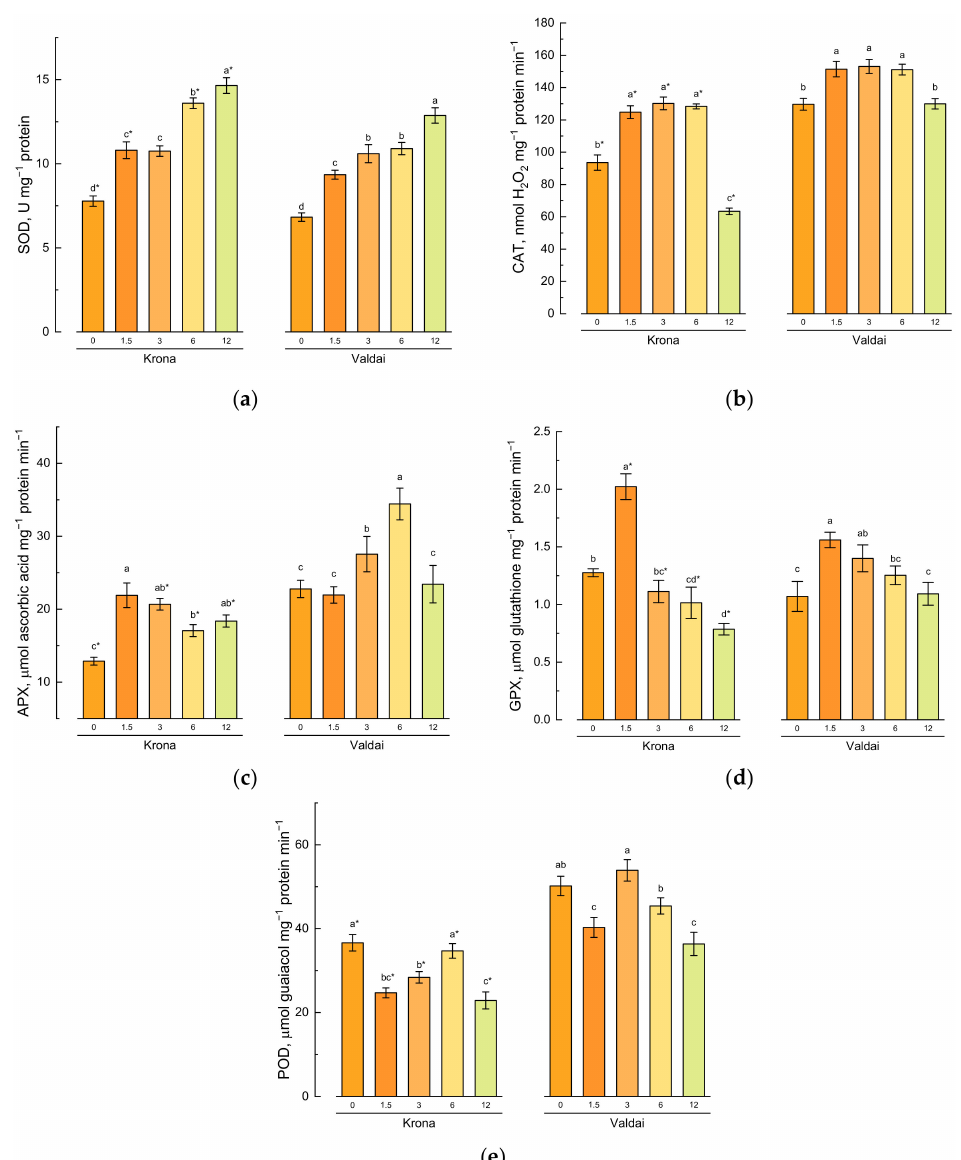
Figure 4. Effect of soil pollution with crude oil (given on X -axis in %) on the activities of antioxidative enzymes: ( a ) superoxide dismutase (SOD), ( b ) catalase (CAT), ( c ) ascorbate peroxidase (APX), ( d ) glutathione peroxidase (GPX) and ( e ) peroxidase (POD) in shoots of two rye varieties. Different lower-case letters indicate significant differences between plants by oil concentration in the soil for each variety separately, and asterisks * indicate significant differences between rye varieties at p ≤ 0.05 based on post hoc Tukey’s test ( n =